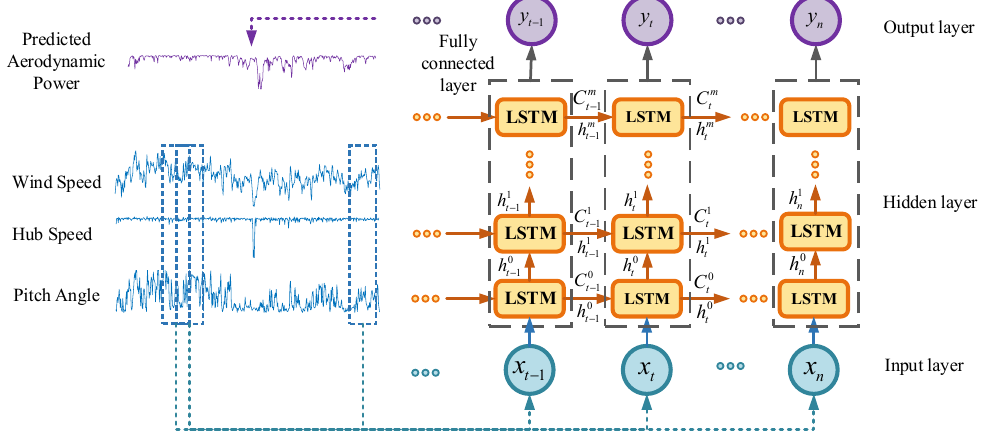
Figure 4. Structure of the aerodynamic power prediction model.